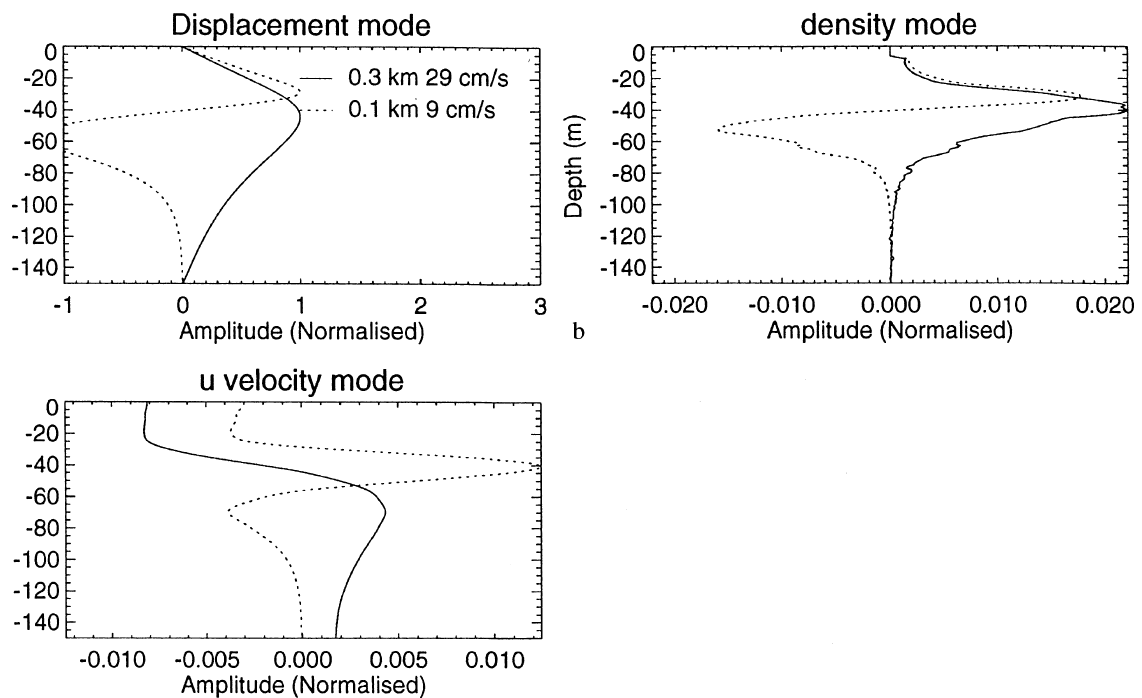
Fig. 11a–c. Linear internal wave modes for the profiles of Fig. 9 and a period of 15 minutes. a Modes of displacement, normalised to a maximum of unity b modes of density perturbation Q and c modes of u (east-west) velocity. Also indicated are the phase speeds in cm s ) 1 and wavelengths